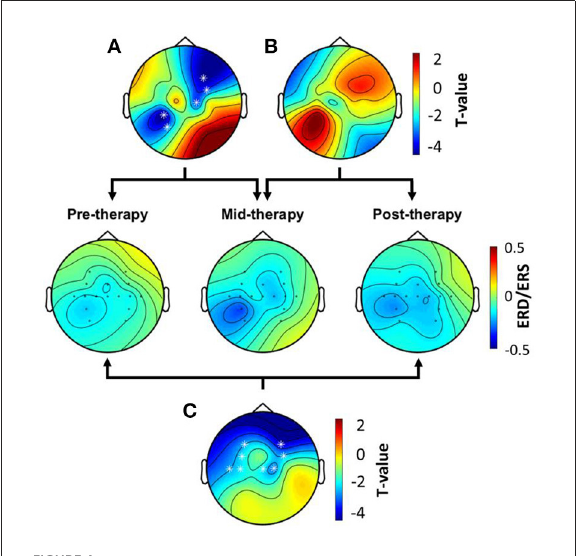
FIGURE4 Topographic maps showing ERD/ERS over time. (A) Significant ERD/ERS differences between pre-therapy and mid-therapy assessed with the cluster-based permutation test. (B) Significant ERD/ERS differences between the mid-therapy and post-therapy. (C) Significant ERD/ERS differences between the pre-therapy and the post-therapy. Significant clusters across therapy stages are marked with white